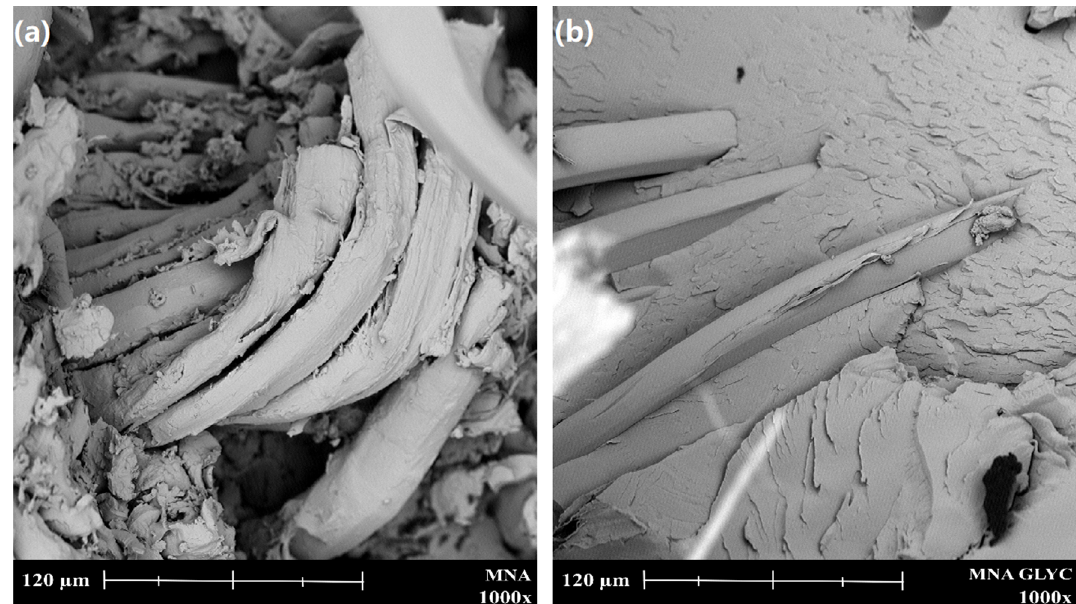
Figure 9. SEM micrographs (1000×) comparing the gap along flax fiber in ELO-based composites cross-linked with ( a ) MNA and no previous surface treatment and ( b ) cross-linked with MNA + previous silanization with glycidyl silane on flax fabric.